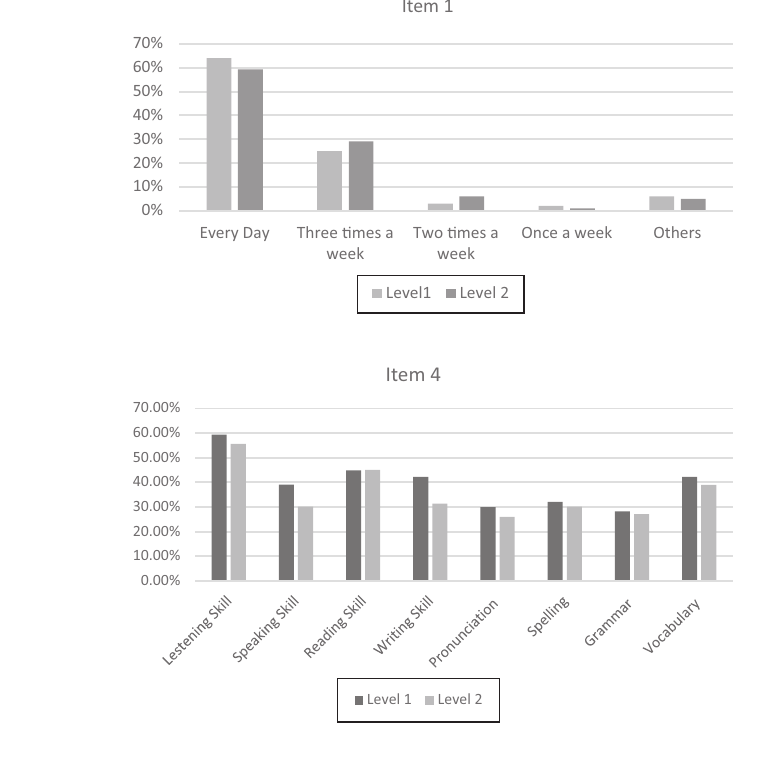
Figure 1. Result of part